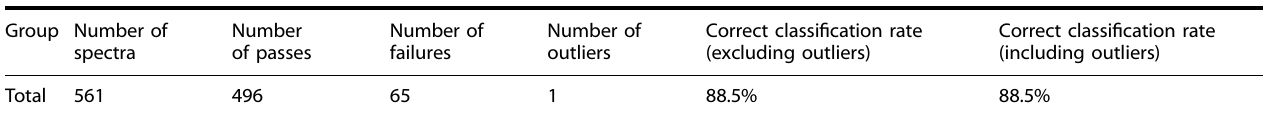
Table 1. Leave-20%-Out cross-validation results for the uncorrected meat cut model. Group Number of spectra